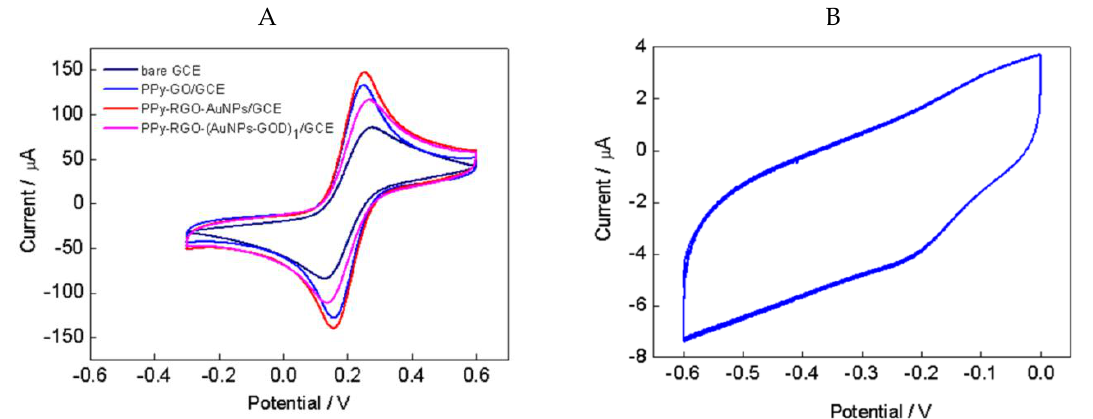
Figure 4. ( A ) CVs of the electrode at different stages: bare GCE; PPy-GO/GCE; PPy-RGO-AuNPs/GCE; and PPy-RGO-(AuNPs-GOD) 1 /GCE. Supporting electrolyte, 0.1 M KCl containing 5mM [Fe (CN) 6 ] 3−/4− (1:1). ( B ) CVs of PPy-RGO-(AuNPs-GOD) 1 /GCE recorded in pH 7.0 phosphate buffer solutions. Scan rate, 50 mV/s.